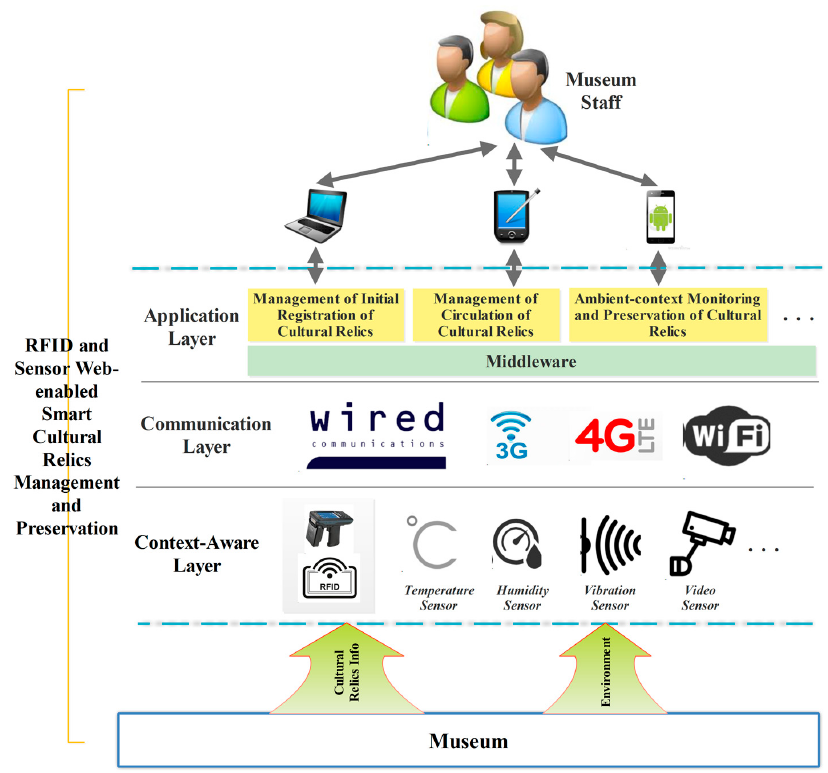
Figure 1. Architecture of the proposed system.